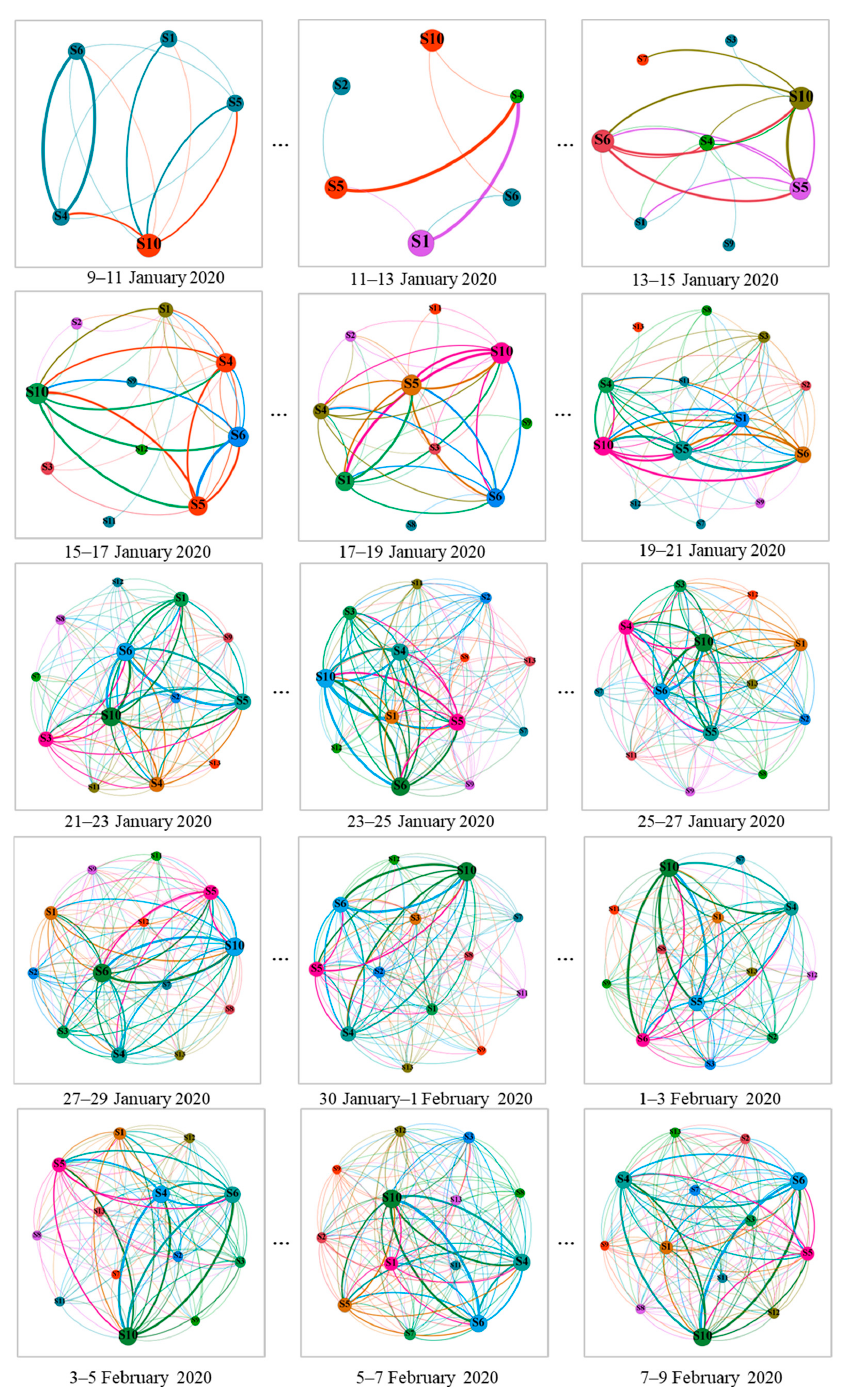
Figure 7. Semantic change network (9 January–9 February 2020) (S1: Fears and worries; S2: Questioning the government and media; S3: Criticizing bad habits; S4: Factual comments; S5: Taking scientific protective measures; S6: Spreading positivity and encouragement; S7: Appeals for help for patients; S8: Expressing willingness to return to work; S9: Other; S10: Staying at home and taking necessary precautions; S11: Spreading anti-epidemic knowledge in the family; S12: Seeking medical help; S13: Seeking relief materials; S14: Appeals for overseas attention; S15: Global epidemic